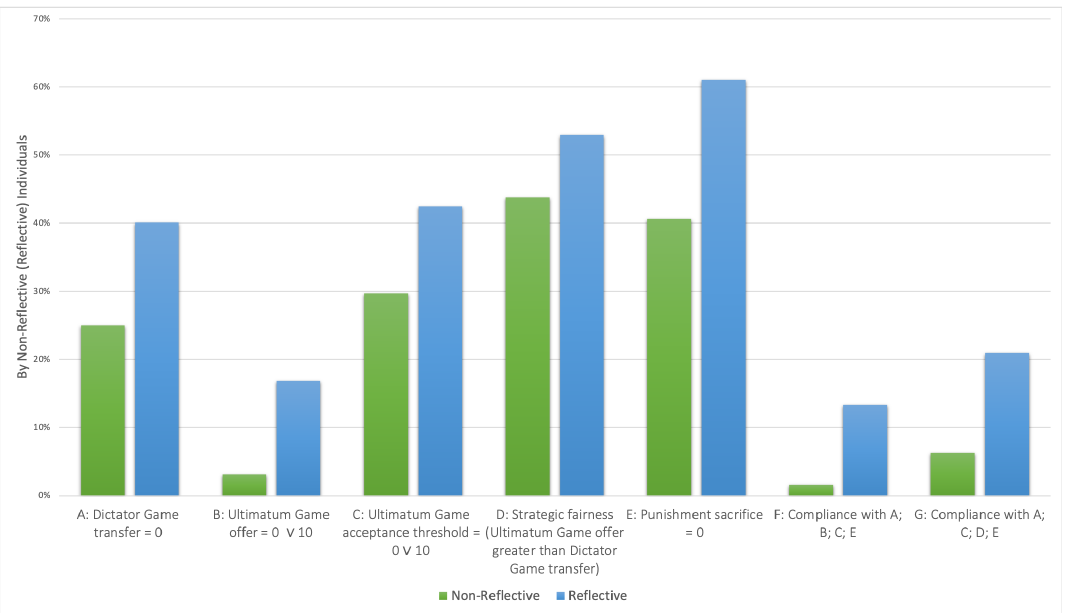
Figure 1. Frequency of Decision by Non-Reflective (Reflective)